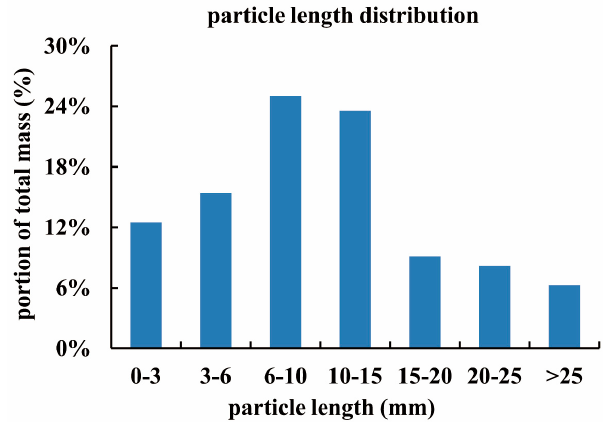
Figure 7. Chopped maize particle length distribution from the tested bunker silo.